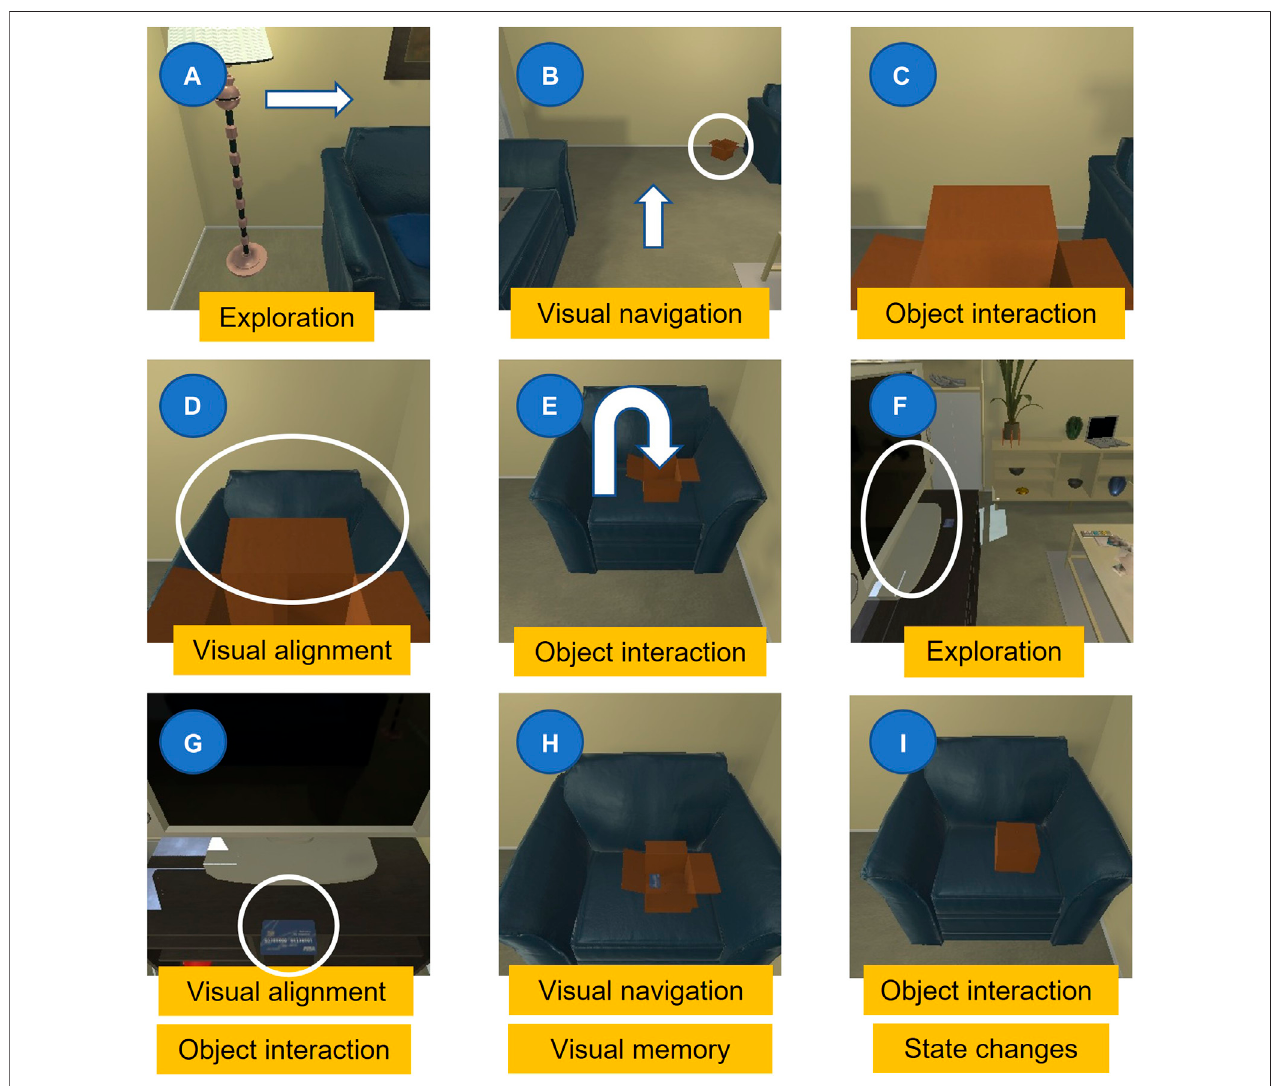
FIGURE1 | Exampleof along horizon compositional task. An overall goal is provided tothe robot through asequence ofinstructions. Combining these withvision atthecurrenttimestep,itmustexecuteactionstosatisfythegoal.Example:Goal: “ Pickupabox,putitonachair,putacreditcardinsideandcloseit. ” (A) : “ Turntowards theothersideoftheroomwiththebluechairincorner. ” (B) “ Walkacrosstheroomtothesmallboxandpickitup. ” (C) “ Turnrightandwalktothefrontofthebluechairin the corner. ” (D) “ Put the box down on the blue chair. ” (E) “ Turn around and walk to the front of the TV stand. ” (F) “ Pick up the credit card from the TV stand. “ (G) “ Turn left and walk back to the blue chair in the corner, put the credit card in the box. ” (H) “ Close the box. “